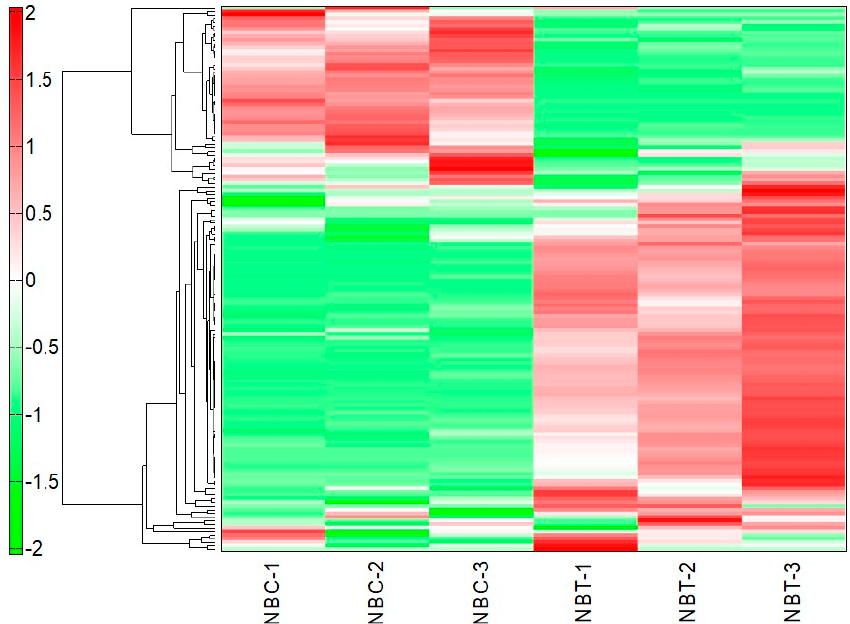
Figure 1. Heat map of the results of the hierarchical cluster analysis of metabolites in the leaves of NbClpC1 / C2 co-suppressed Nicotiana benthamiana. The horizontal and vertical axes show sample names and peaks, respectively. The distances between samples and between peaks are displayed in three diagrams. NBC-1, 2, 3: Control 1, 2, and 3; NBT-1, 2, 3: NbClpC1 / C2 co-suppressed N. benthamiana 1, 2 and 3.